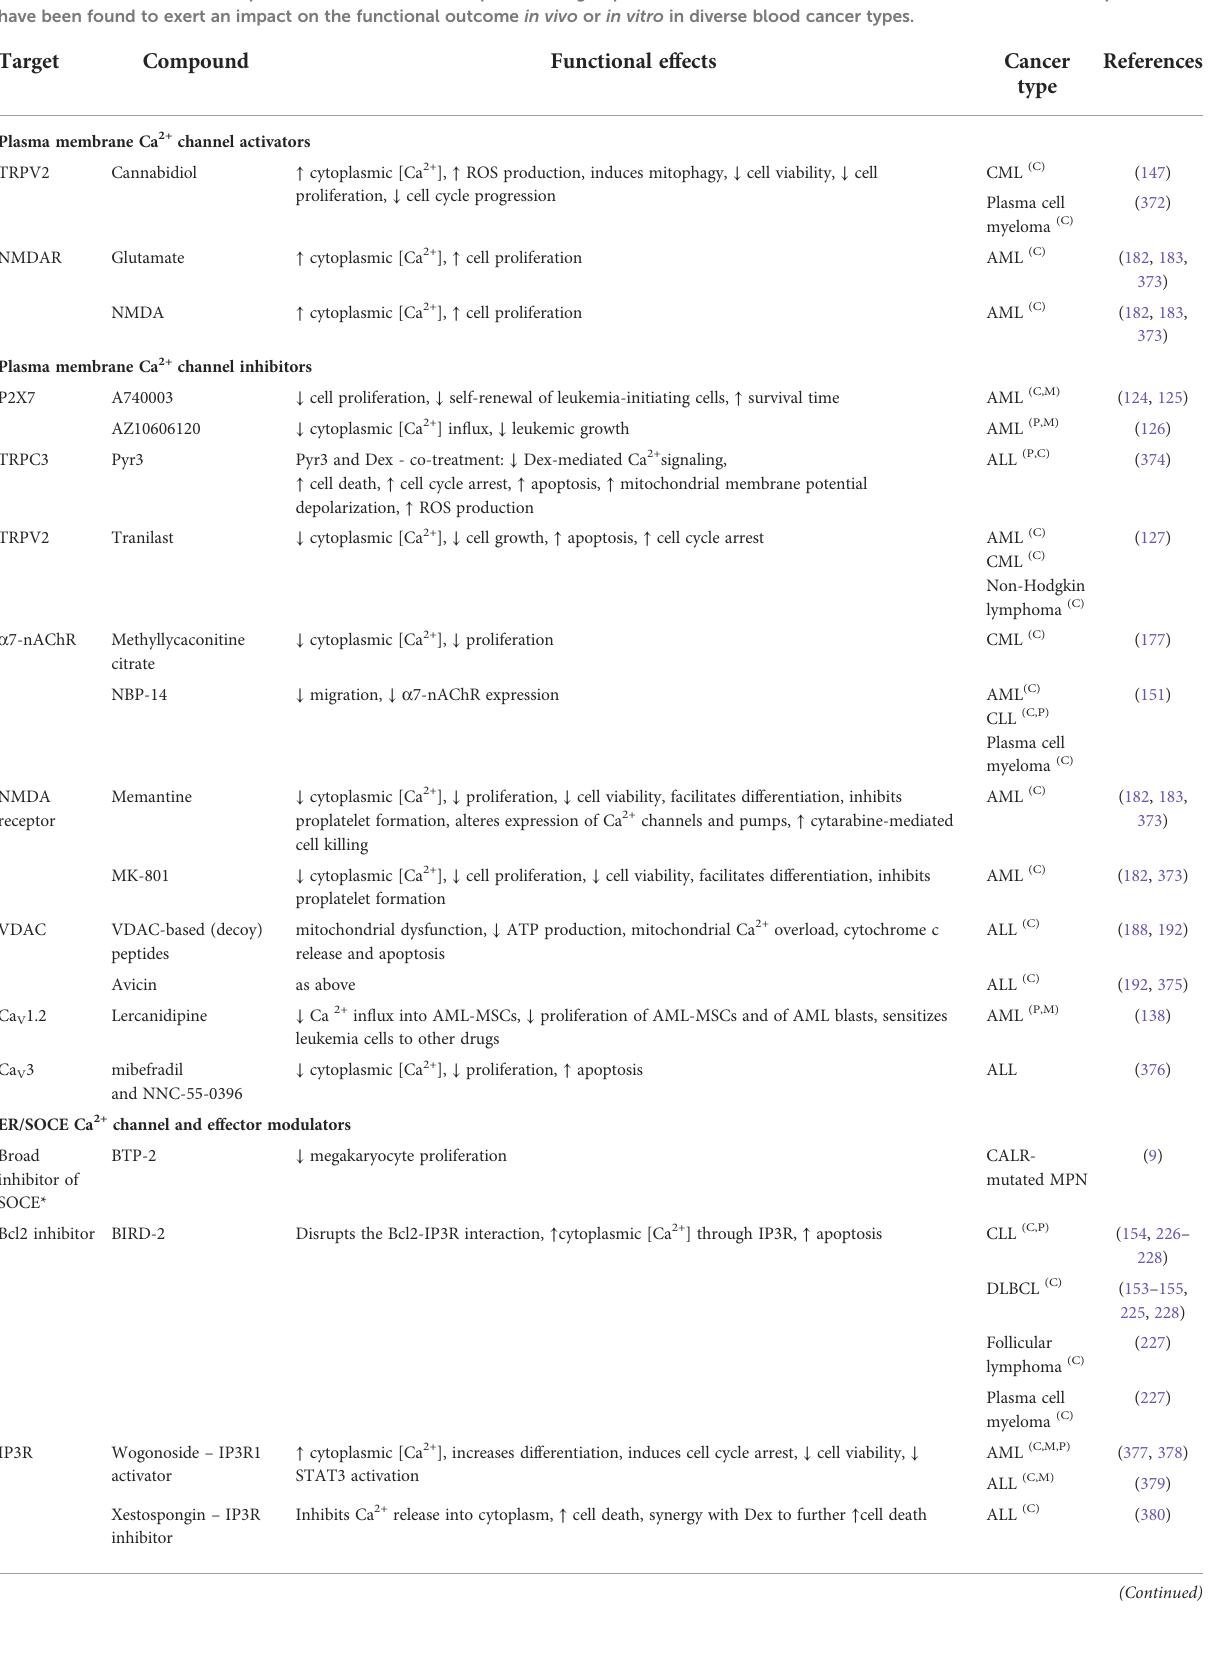
TABLE 4 Demonstrative examples of calcium-related compounds/drugs (speci fi c inhibitors or activators of calcium channels and receptors) that have been found to exert an impact on the functional outcome in vivo or in vitro in diverse blood cancer types.